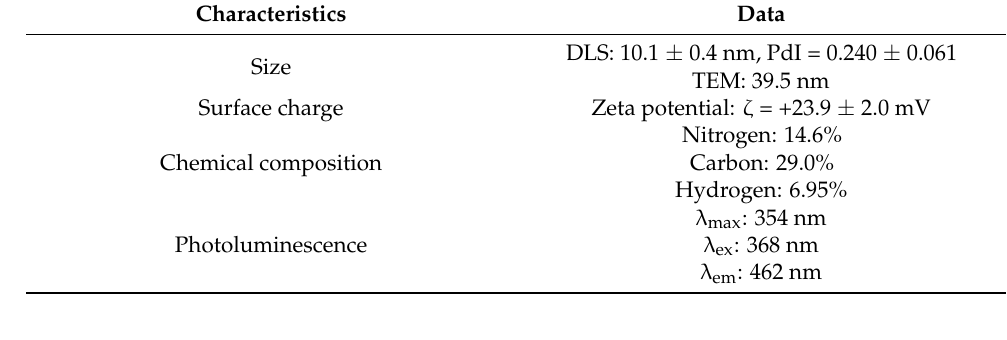
Table 1. Physicochemical characteristics of CDs.